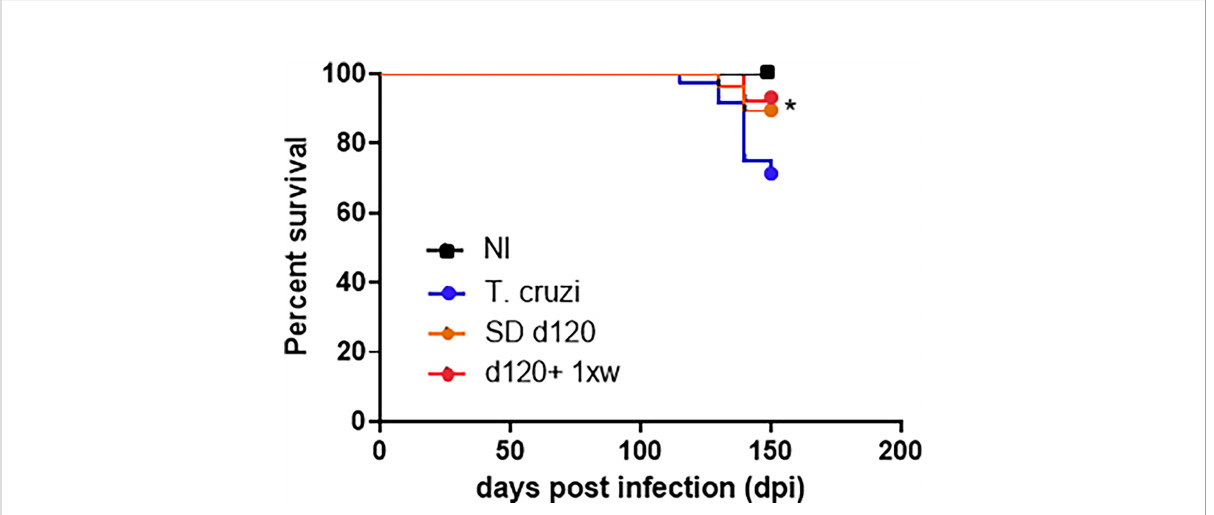
FIGURE 4 1D11 treatment increased mice survival rates in chronically T. cruzi- infected mice. After 120 dpi 1D11 was administered in two schemes: single dose at 120 dpi (SD d120) and starting at 120 dpi + once a week (d120+ 1xw). Signi fi cant differences between non infected and infected mice treated or not with 1D11 are indicated by *p< 0.05.